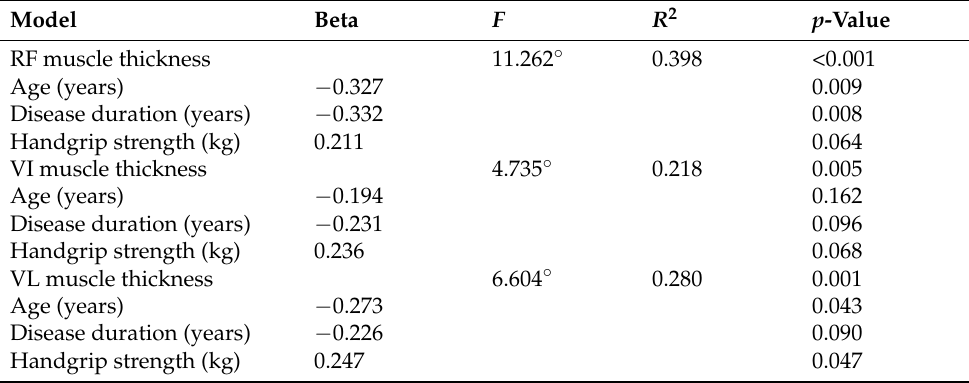
Table 3. Linear regression models for muscle mass (RF, VI and